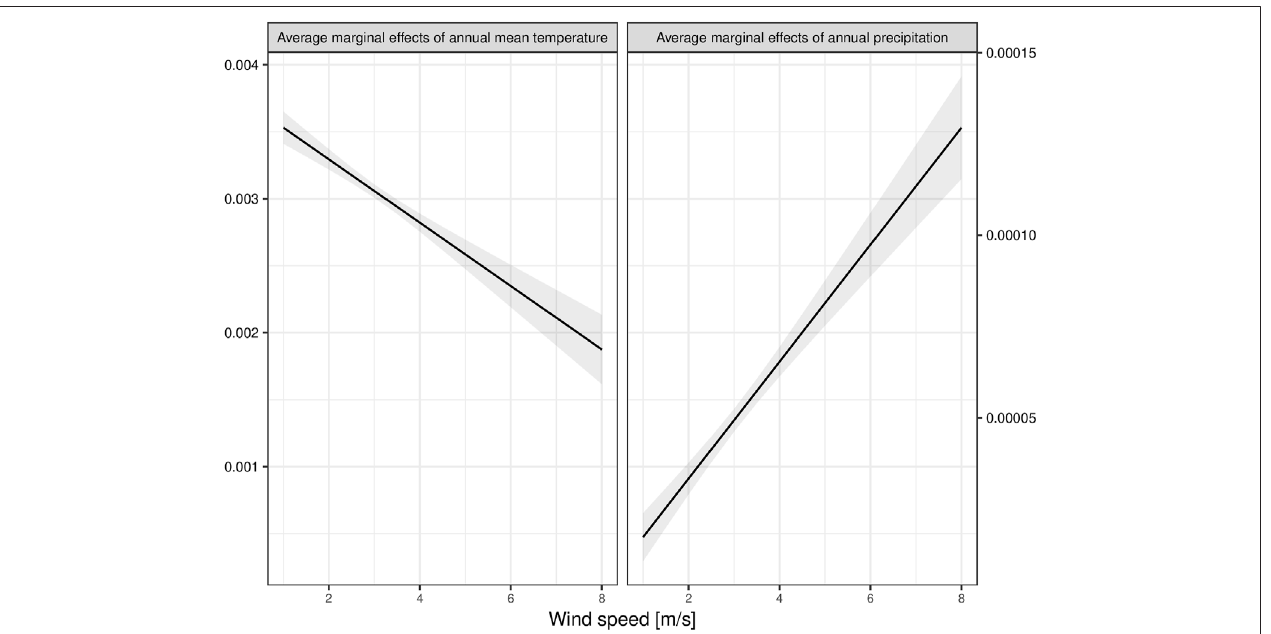
FIGURE 3 | Effects of increasing wind speed on the average marginal effect of (A) the annual mean temperature and (B) the annual precipitation on the predicted habitat suitability of Aedes albopictus . The average marginal effect of the annual mean temperature decreases with increasing wind speed, and the average marginal effect of the annual precipitation